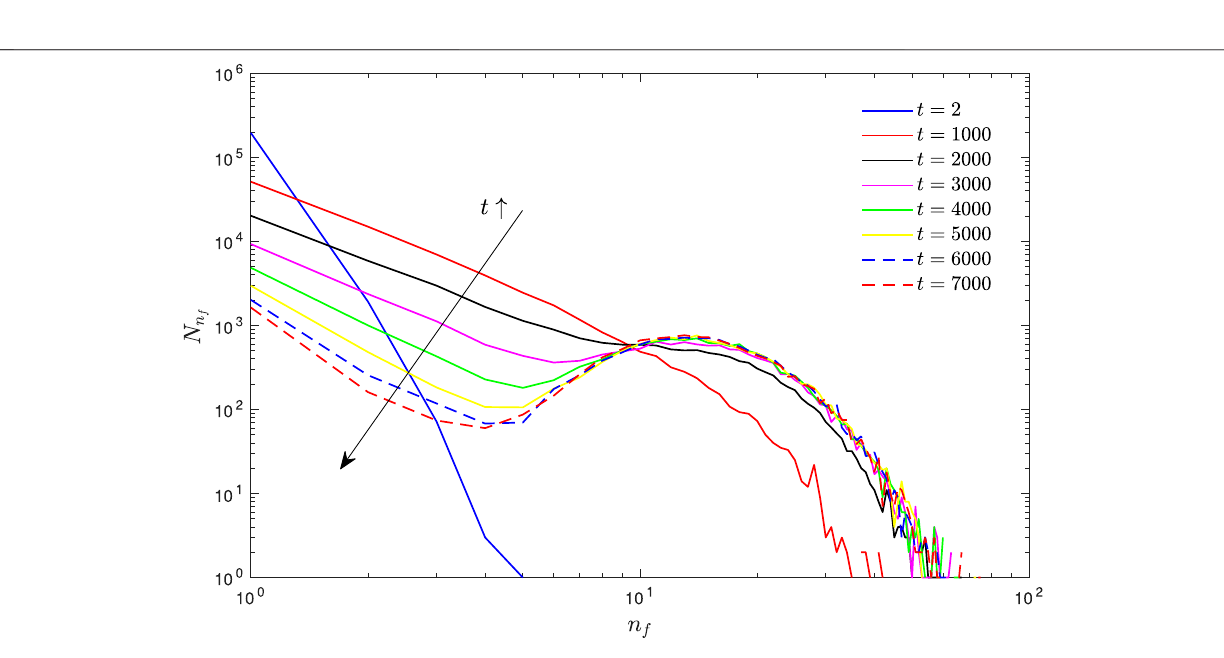
Frontiers in Earth Science |